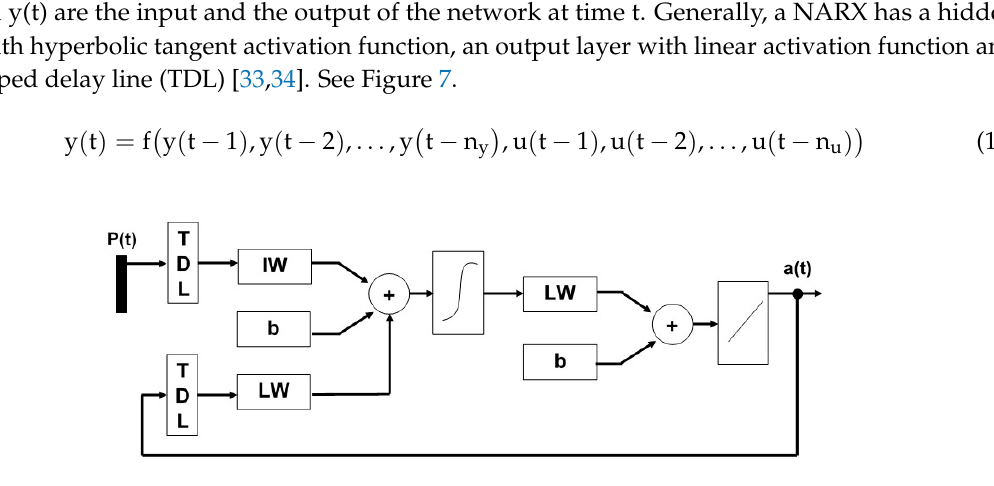
Figure 7. Recurrent dynamic network with exogenous inputs (NARX).